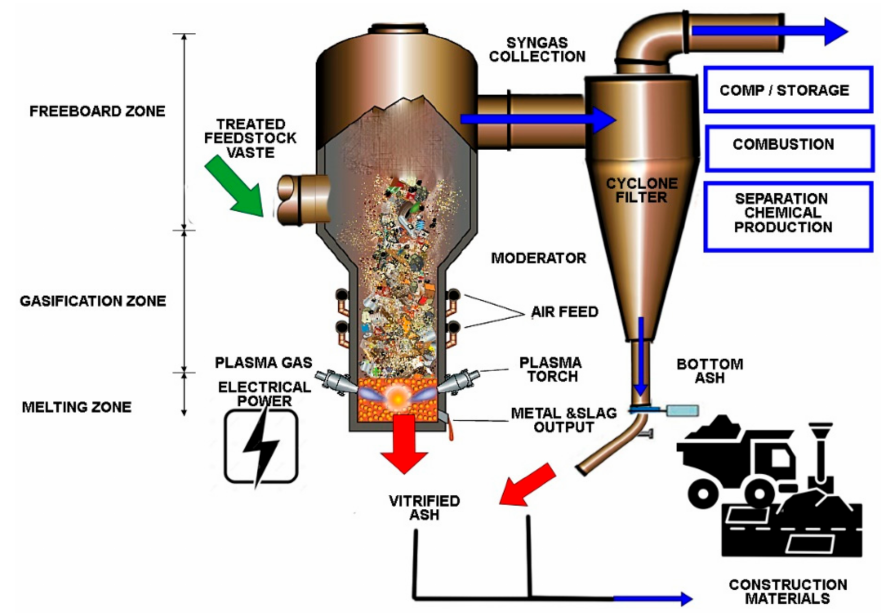
Figure 1. Plasma gasification set up and downstream utilization of the syngas